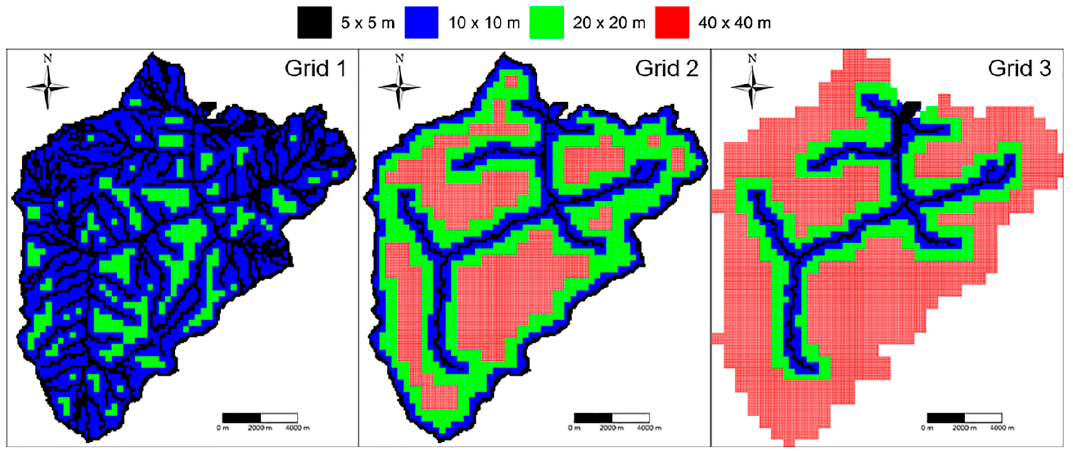
Figure 15. Multiresolution grids: from left to right BUQ Grid 1, 2 and 3.